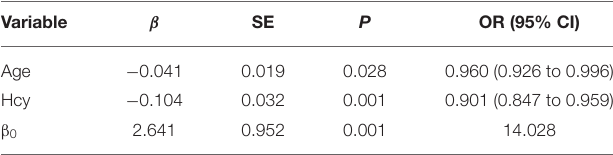
TABLE 3 | The results of logistic regression